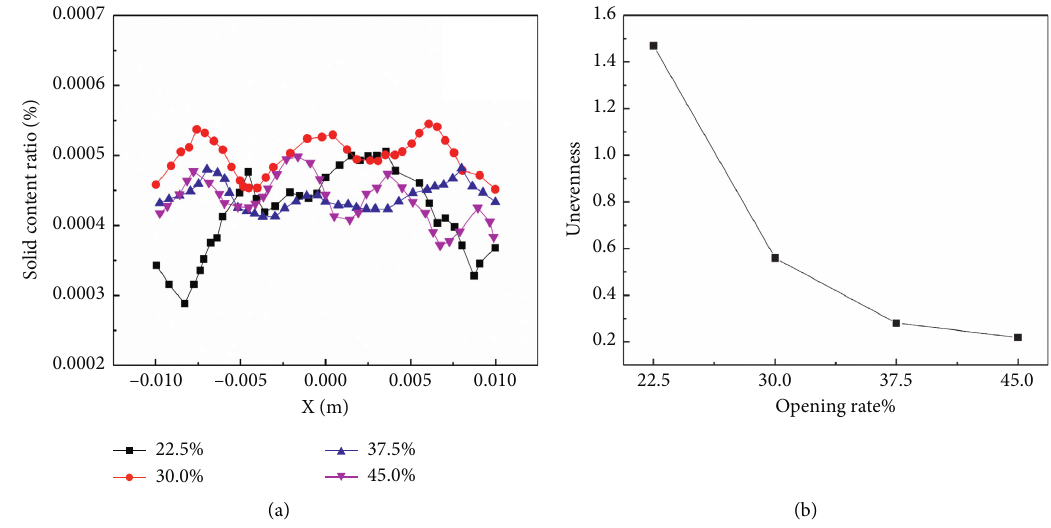
Figure 4: Influence of the porosity of the multiwell plate on the distribution of nanomagnetic enzymes. (a) Different multiorifice of magnetic particle density distribution of enzyme. (b) Different multiorifice when the magnetic particle density distribution of